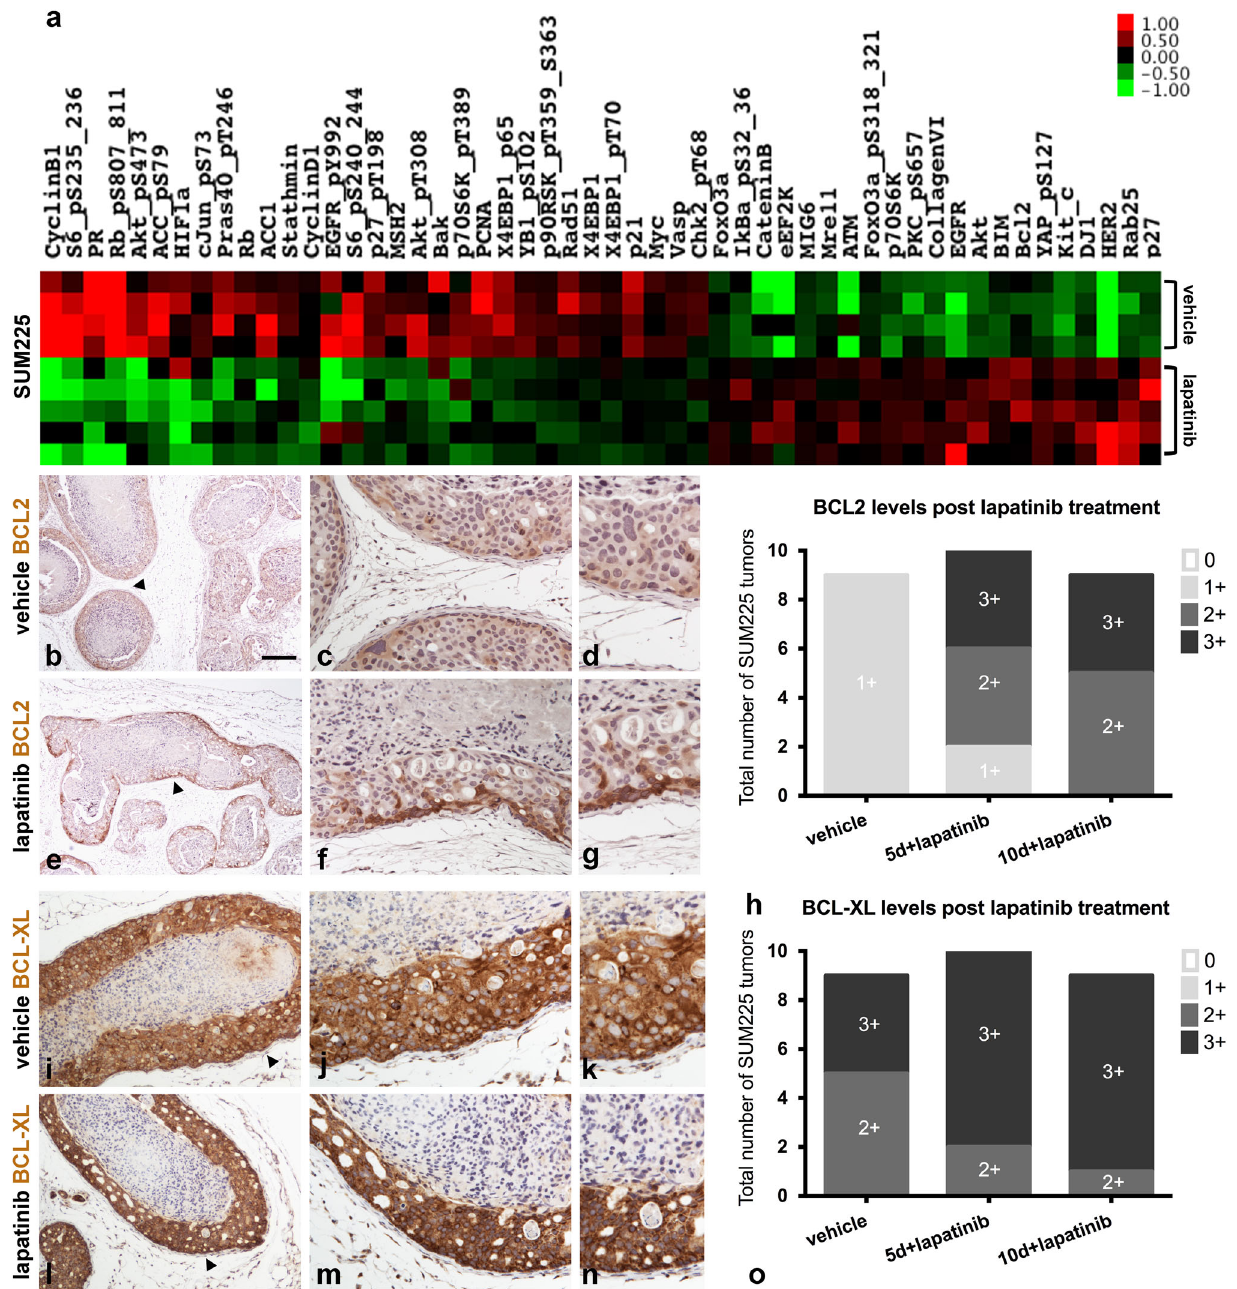
Fig. 2 Lapatinib induces pro-survival BCL2 in the niche-protected tumor cells. a RPPA analysis of SUM225 vehicle and 10-day lapatinib-treated tumors. Proteins with signi fi cant differences (unpaired two-tail Welch ’ s t test p value < 0.05) between lapatinib-treated and vehicle-treated tumors are shown. Data are log2 transformed and median centered. Statistical analysis was performed in R v.3.2.2. The RPPA heatmap was generated in Cluster v.3.0 and Java TreeView v.1.1.1. b – g Matched tumor sections were assayed for BCL2 via IHC. Representative vehicle- treated and lapatinib-treated tumors from two independent experiments are presented. IHC assays con fi rmed the RPPA results and highlighted selective BCL2 induction within niche-localized tumor cells. h BCL2 levels were scored according to intensity as 0, 1+, 2+, or 3+ and summarized across multiple tumors from two independent experiments (Fisher ’ s exact test vehicle vs. 5-day lapatinib; p value = 0.0007145 and vehicle vs. 10-day lapatinib p value = 4.114e-05). Post lapatinib, BCL2 expression was largely localized within the outermost tumor cells. i – o Lapatinib treatment did not alter expression of the pro-survival protein BCL-XL. Note SUM225 tumors express moderate to high BCL-XL levels with or without treatment and throughout all viable cells (Fisher ’ s exact test vehicle vs. 5-day lapatinib; p value = 1.083e-05 and vehicle vs. 10-day lapatinib p value = 4.114e-05). Fisher ’ s exact tests were performed in R v.3.2.2. Arrowheads ( b , e , i , l ) highlight regions magni fi ed in subsequent panels. Scale bar, ~200 μ